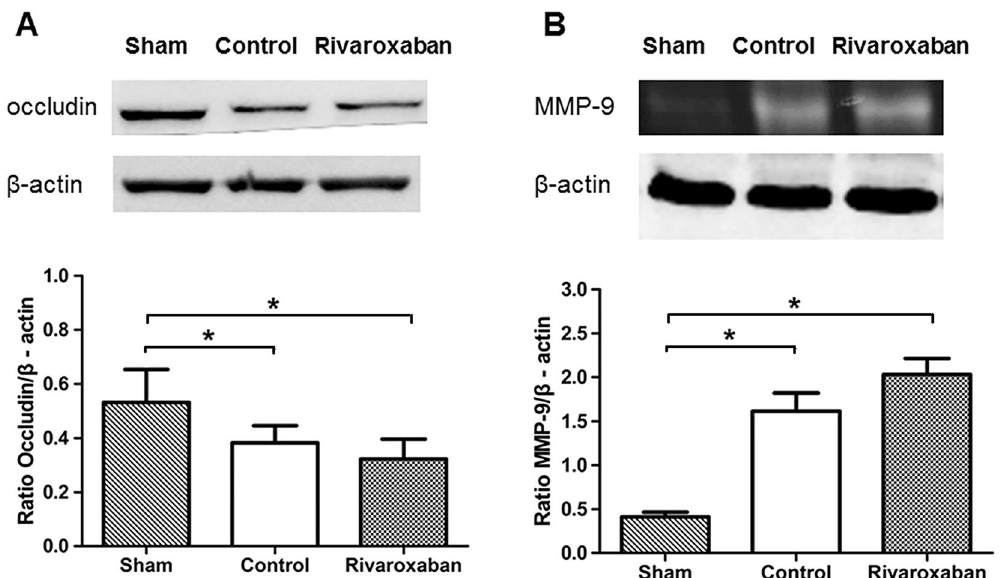
Figure 5. Effects of Rivaroxaban on occludin expression and MMP-9 activity in rats. ( A ) A representative western blot showing changes in occludin expression (n = 6 in each group). Both the Control and Rivaroxaban groups have significantly lower occludin expression level than the Sham group ( * P < 0.05), while the Control and Rivaroxaban group have similar occludin expression level ( P = 0.28) (one-way ANOVA and a LSD test for post hoc comparisons). ( B ) A representative zymogram showing changes in MMP-9 activity (n = 6 in each group). Both the Control and Rivaroxaban groups have significantly higher MMP-9 activity than the Sham group ( * P < 0.05), while the Control and Rivaroxaban group have similar MMP-9 activity ( P = 0.08) (one-way ANOVA and a LSD test for post hoc